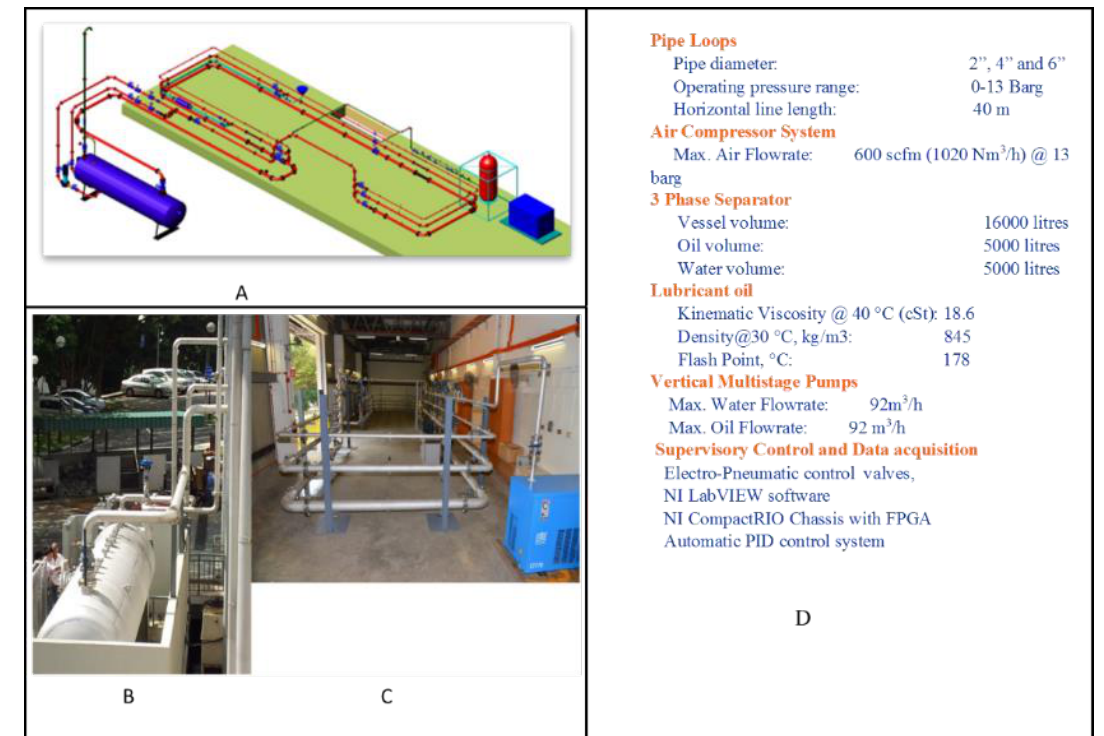
Figure 3. Schematic views and pictures of the experimental setup: ( A ) full 3D view, ( B ) separator tank, ( C ) pipe flow loops, ( D ) specifications [30] .